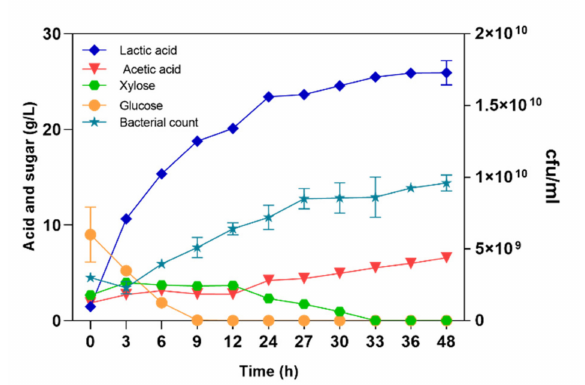
Figure 2. Lactic acid production from NaOH-pretreated and washed corn stover (4% w / w ). The final cellulase concentration was 30 FPU / g stover. Diamonds indicate lactic acid. Inverted triangles represent acetic acid. Dots indicate glucose. Polygons represent xylose. Pentacle represent bacterial count. The three fermentation stages are presented in the